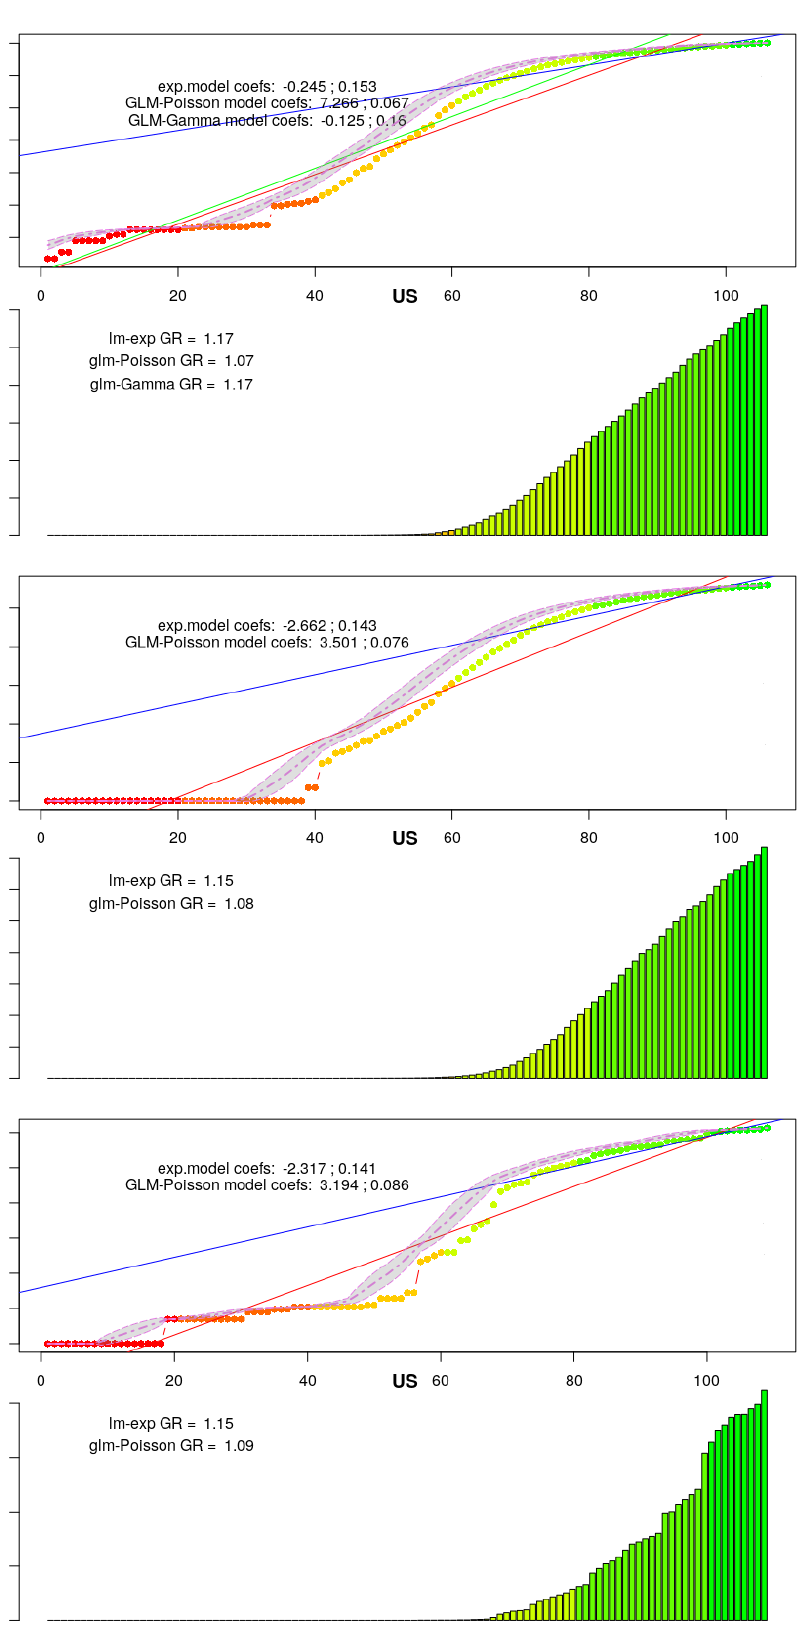
Figure 2. U.S. COVID-19 confirmed cases ( top ), deaths ( middle ), and recovered cases ( bottom ) extracted from the